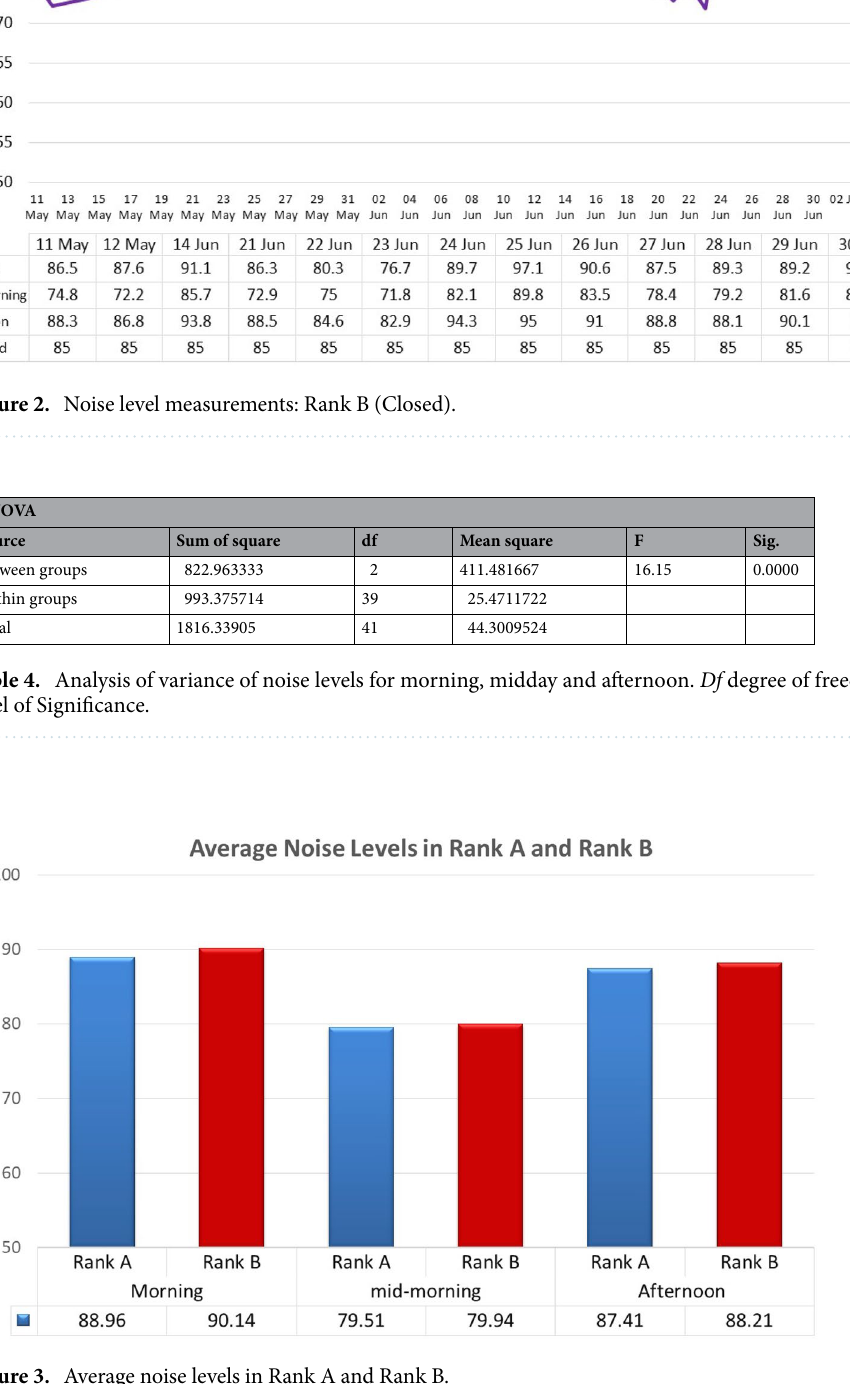
Figure 3. Average noise levels in Rank A and Rank